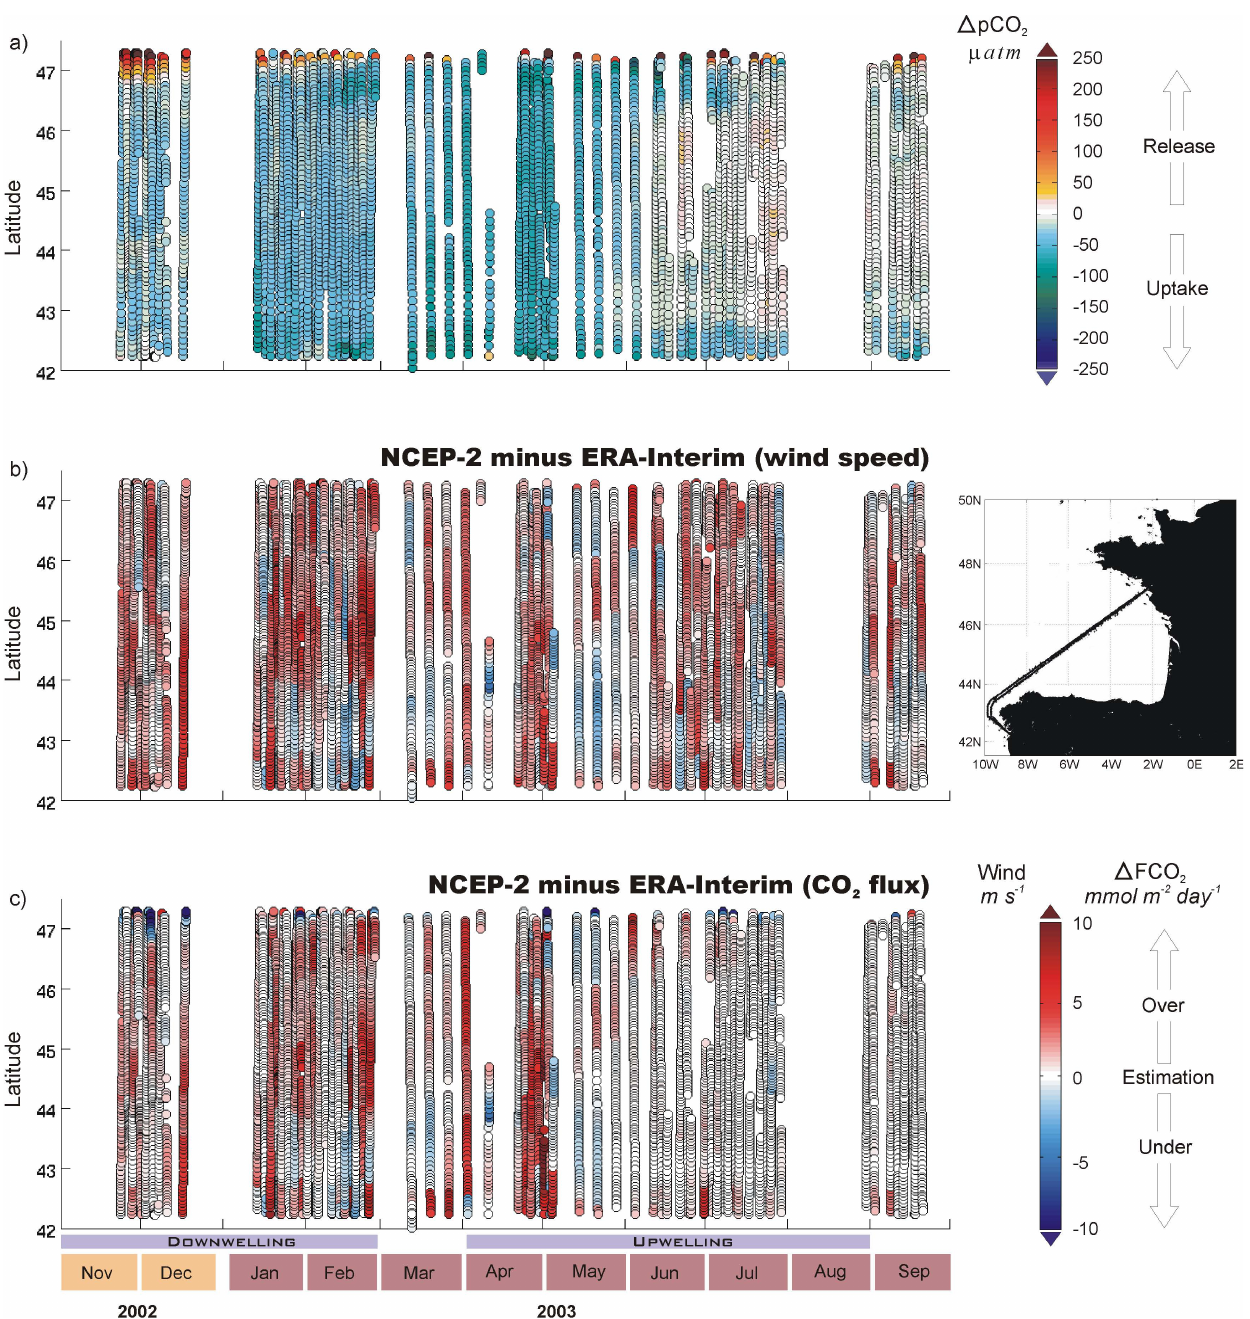
Fig. 3. (a) Distribution of underway 1p CO 2 measurements in the Bay of Biscay gathered during ECO cruises. Positive (negative) means release (uptake). (b) Wind speed difference between NCEP-2 and ERA-Interim. (c) Difference of F CO 2 computed using NCEP-2 and ERA- Interim, both with the same algorithm by Wanninkhof (1992). Points along the route are drawn approximately each 30min of navigation.